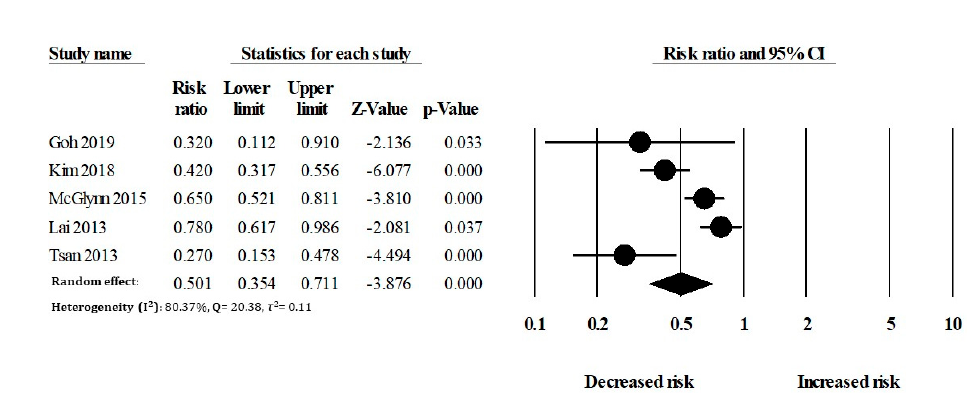
Figure 5. Statin use and the risk of hepatocellular carcinoma (HCC) in patients with ( A ) liver cirrhosis and ( B ) without liver cirrhosis.